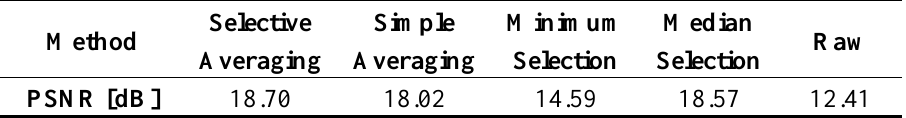
Table 4. PSNR of the image in each method and